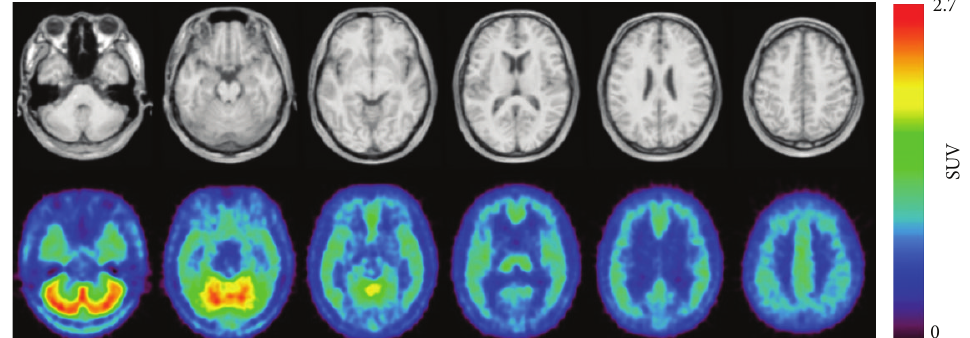
Figure 9: PET/MRI images of [ 11 C]ITMM (40–60 min) obtained from 5 healthy human subjects. Upper: MR image and lower: averaged [ 11 C]ITMM PET image